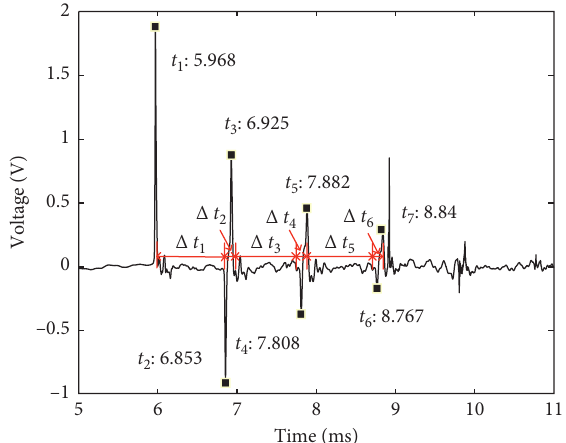
Figure 7: Voltage-time diagram of stress waves and reflected waves detected by strain